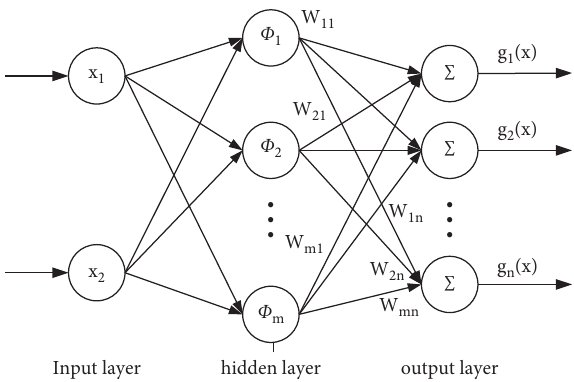
Figure 3: The structure of the RBF neural